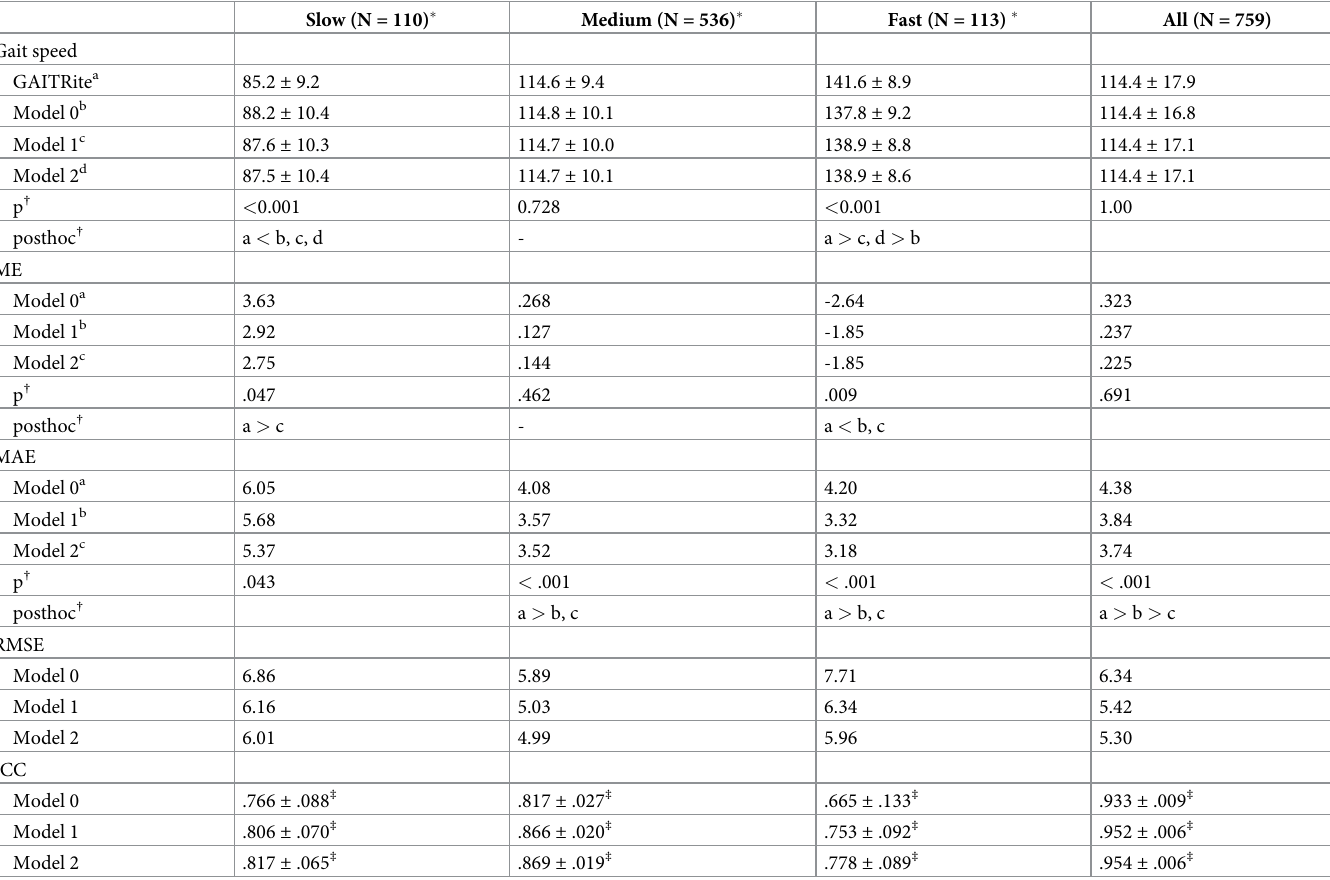
Table 5. Comparison of the accuracies of the three gait speed estimation models. The values predicted by the models were compared to the values obtained with the GAITRite ™